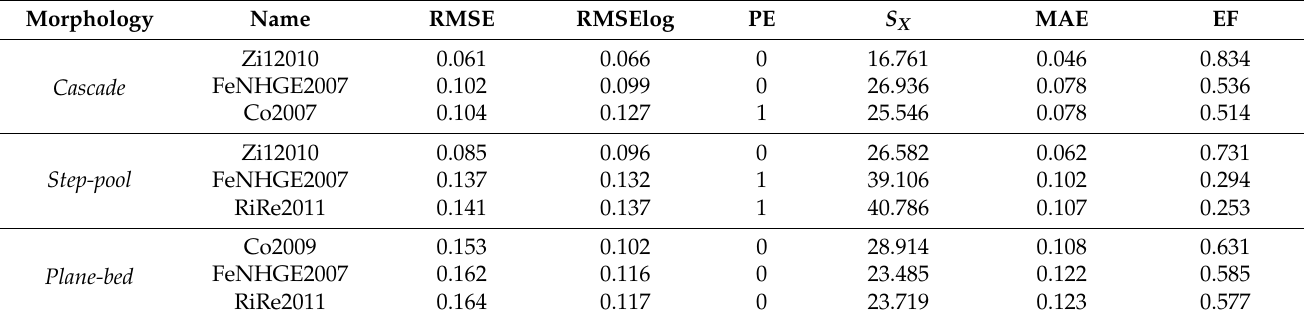
Table 4. Statistical fitting metrics for Cascade , Step-pool , and Plane-bed morphologies.